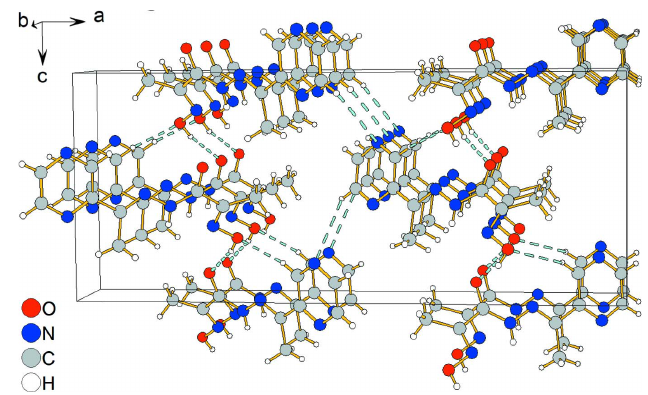
Figure 2 Crystal packing of the title compound 1 . Hydrogen bonds are indicated by dashed lines.